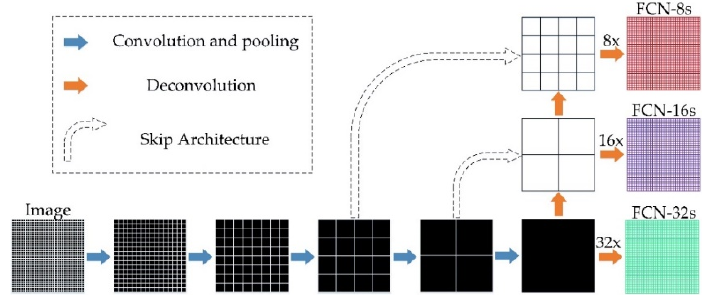
Figure 6. Structure of FCN-8s, FCN-16s, and FCN-32s.